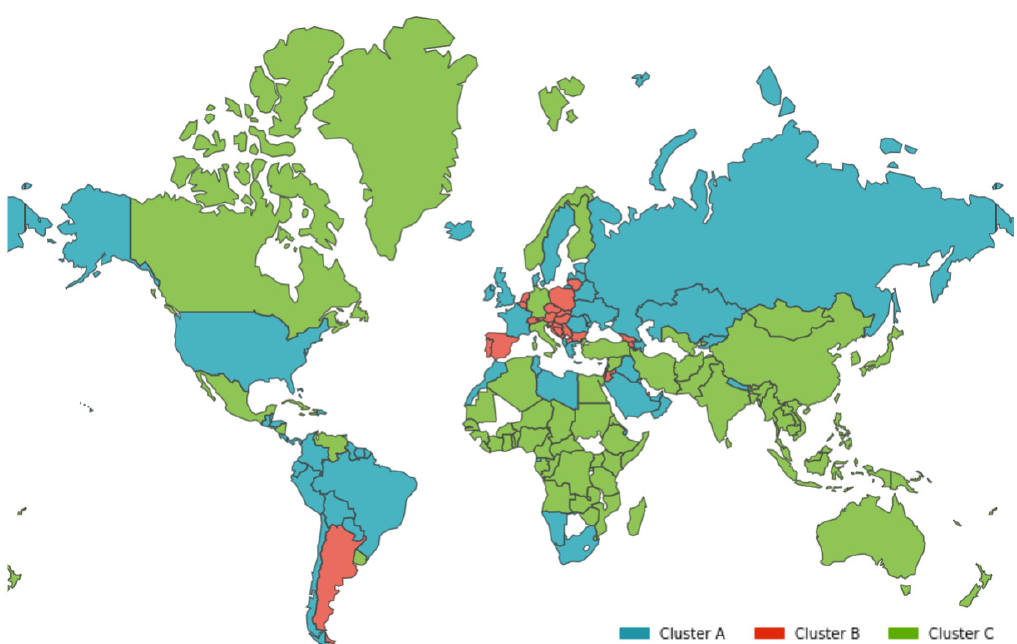
Figure 4. Timeline of first case reporting by country (due to space constraints, countries’ names are shown in ISO 3166 alpha 3 codes).